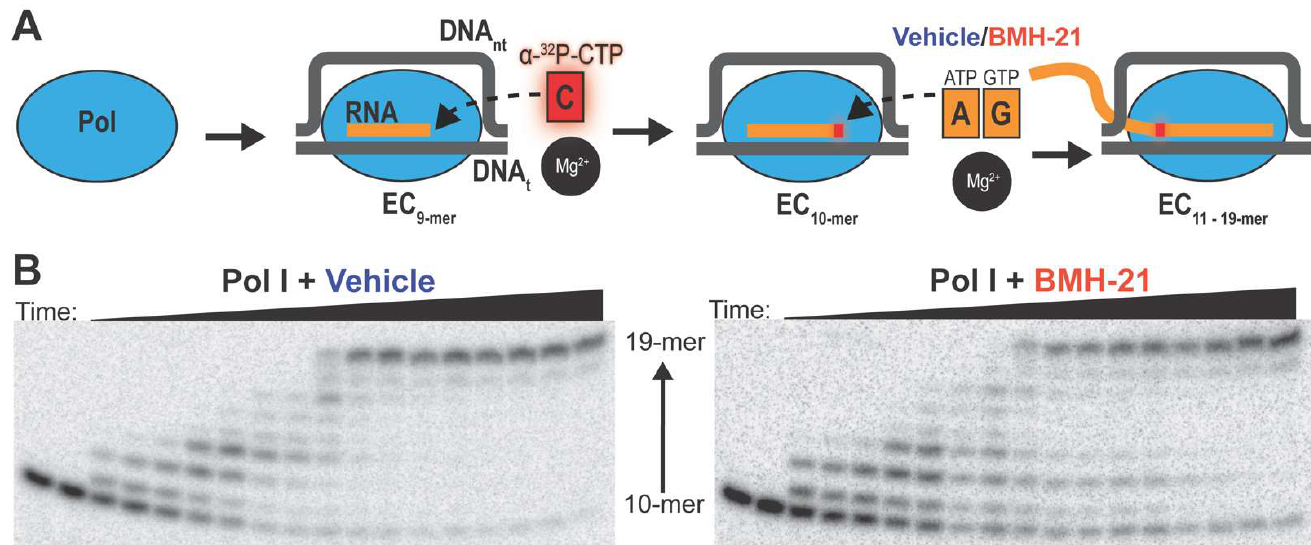
Figure 1. Schematic of multi-nucleotide addition experiment in the presence of vehicle or BMH-21. ( A ) Schematic for multi-nucleotide addition assay. Elongation complexes (ECs) are formed with Pol I, II, or III, RNA:DNA t hybrid, and DNA nt . ECs are radiolabeled with α- 32 P-CTP in the presence of Mg 2+ , allowing the formation of a EC 10-mer . Radiolabeled ECs are incubated with vehicle or BMH-21 (1 μM) for 5 min. ECs are loaded into a chemical quenched-flow instrument and rapidly mixed with ATP (1 mM), GTP (1 mM), and Mg 2+ (9 mM). Time points are collected over a time course, (0.005–10 s), and run on polyacrylamide sequencing gels to resolve the RNA intermediates, 10-mer–19-mer. ( B ) Representative gels of Pol I multi-nucleotide addition time courses collected in the presence of vehicle, left, or BMH-21 (1 μM), right.